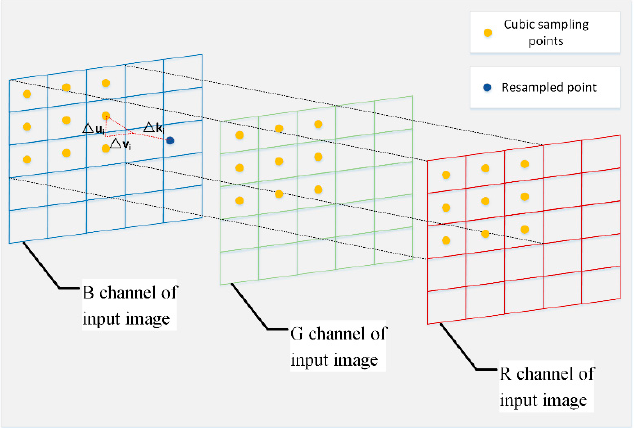
Figure 4. The learning procedure of three-dimensional deformable sampling locations. After the prediction of the offsets, the input image is resampled using a trilinear interpolation method according to the predicted offsets, as expressed below.